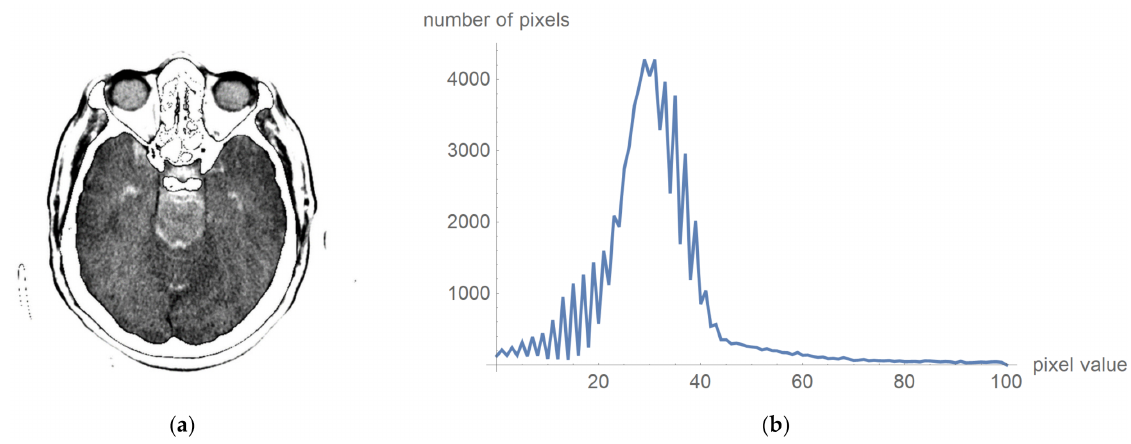
Figure 6. Original image multiplied by the mask and its histogram: ( a ) the negative of the original image multiplied by the mask; and ( b )its histogram, whose pixels are higher than 0 and less than